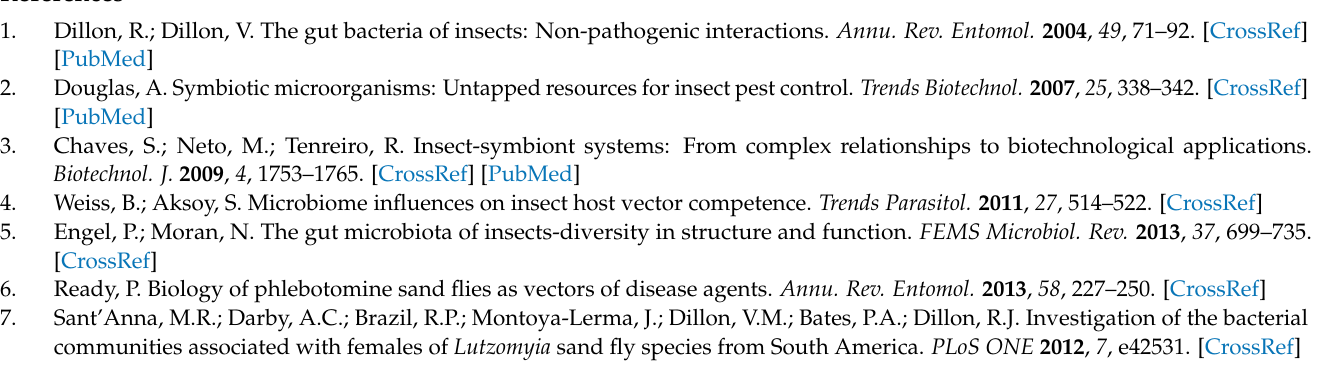
flies, Figure S2: The fungal genus composition of the Lutzomyia ayacuchensis population collected from Ayacucho. Table S1: Sequence reads from each RNA sample collected from southern